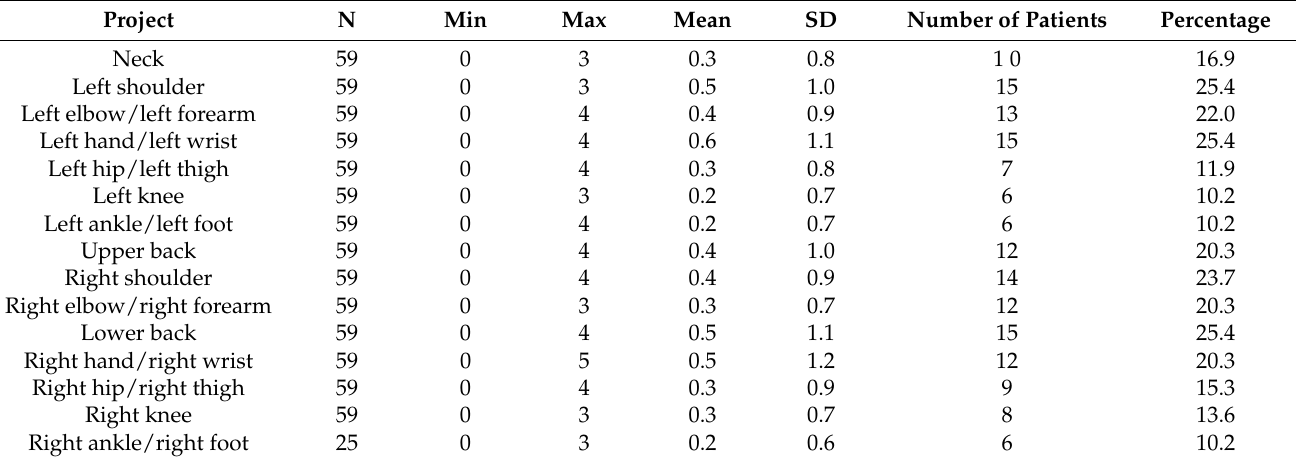
Table 3. Musculoskeletal status of